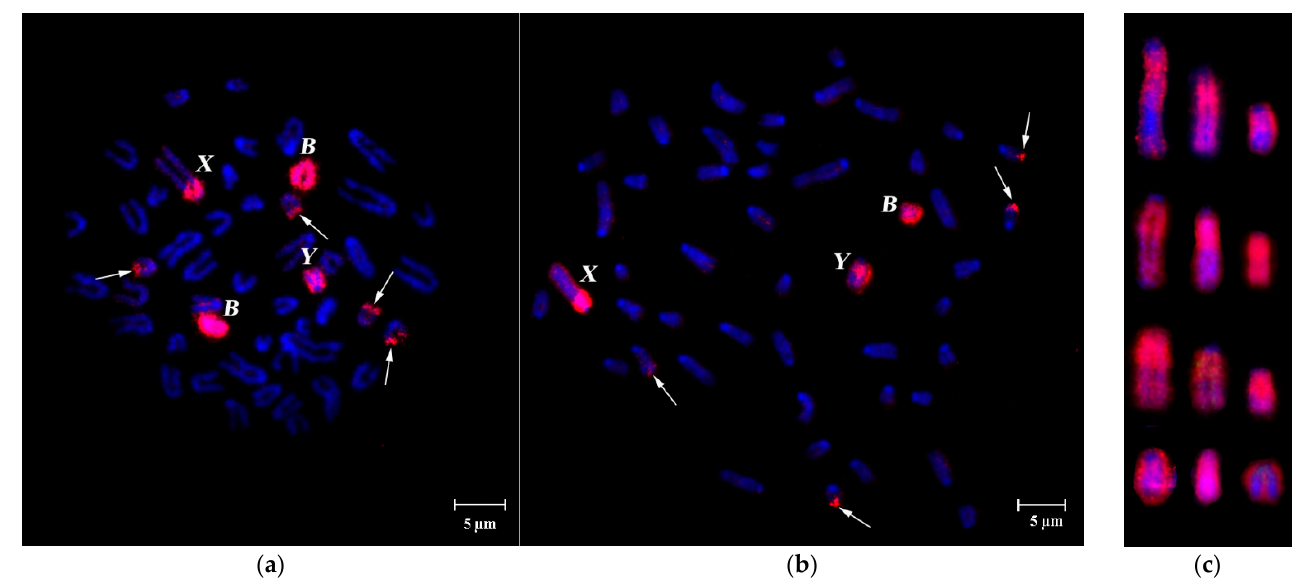
Figure 1. FISH of B-specific Whole Chromosome Paint (WCPB) (red signal) onto metaphases of females with one B chro- mosome from different populations of A. flavicollis . ( a ) WCP3977B probe (from a specimen from Petnica, Serbia) hybrid- ized onto metaphase plate from fibroblast cell culture of female #3980 (Orašac, Serbia); ( b ) WCP3980B probe (from a spec- imen from Orašac, Serbia) onto a metaphase plate from bone marrow cells of female #26368 (Ulyanovsk region, Russia). Bs and X chromosomes are marked by corresponding letters; arrows indicate heterochromatic blocks on four small auto- somes. DAPI total chromosome staining is blue. Scale bar 5 µm.